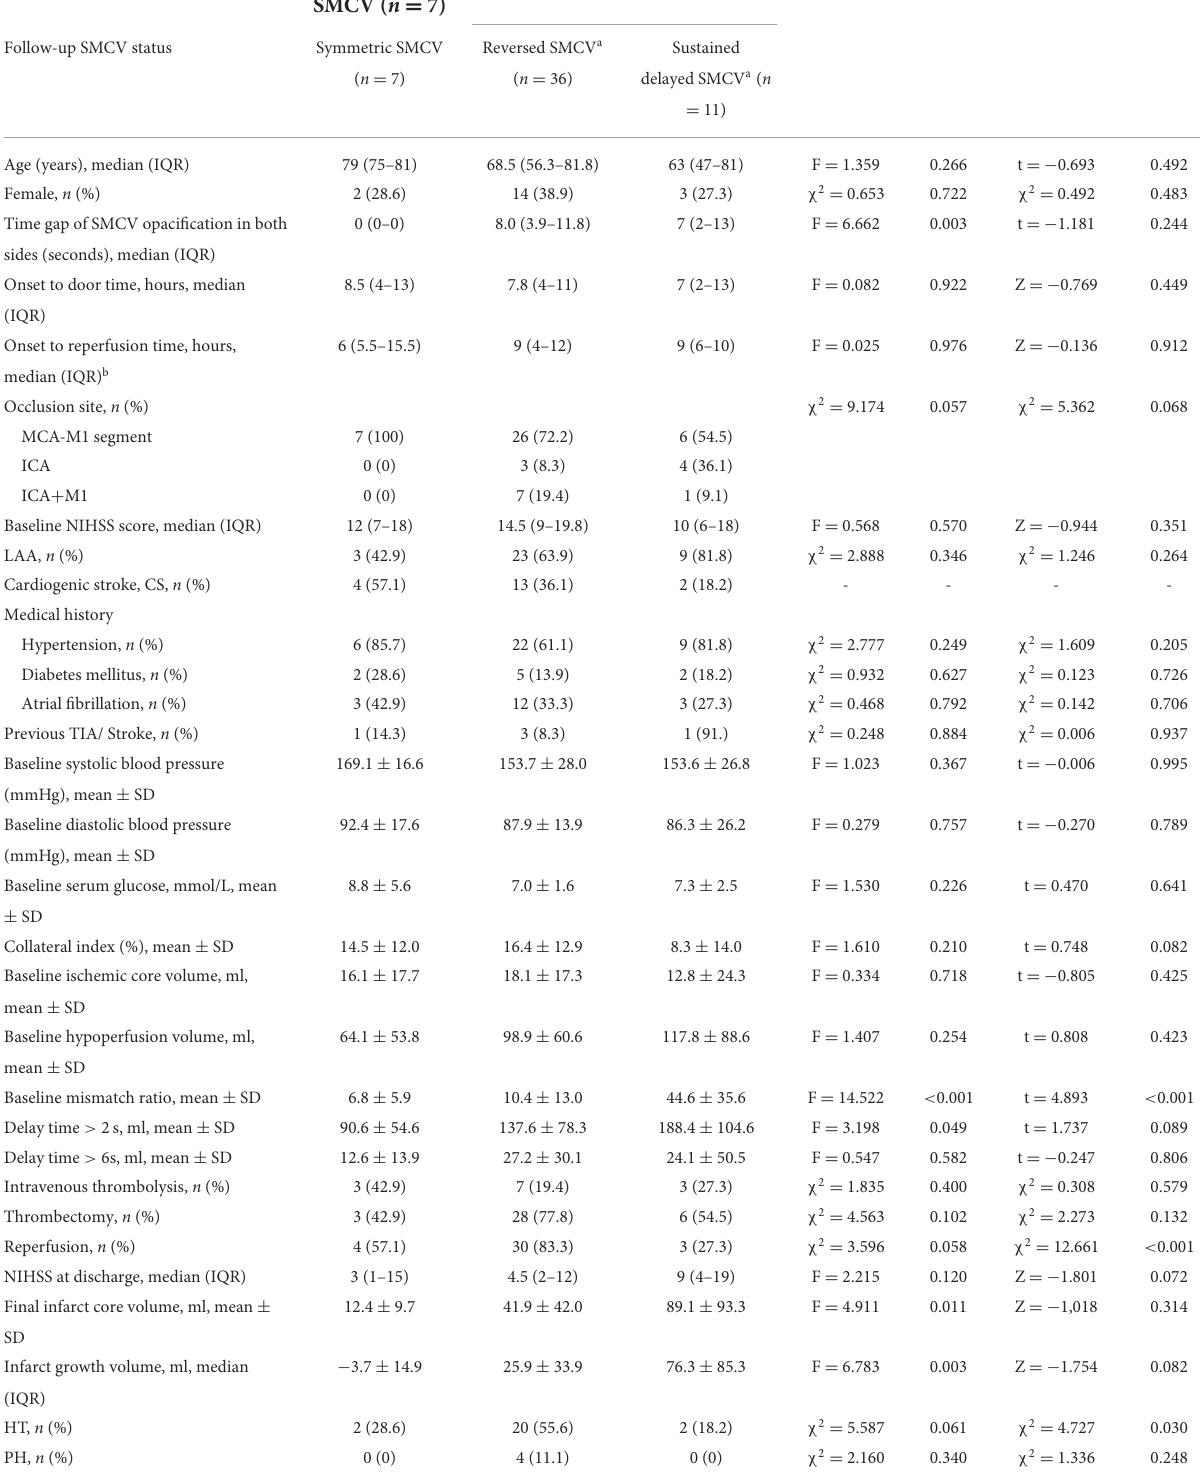
TABLE 1 Baseline and follow-up characteristics of patients stratified by the SMCV